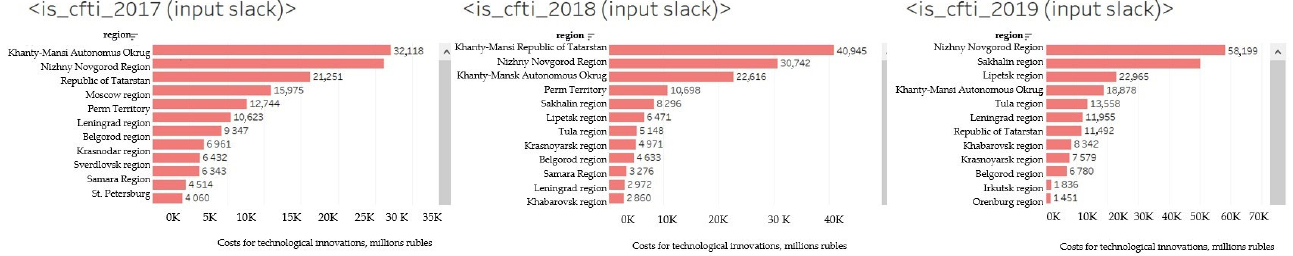
Figure A2. Size of incoming slacks by the indicator costs for technological innovations in Russia 2017–2019.